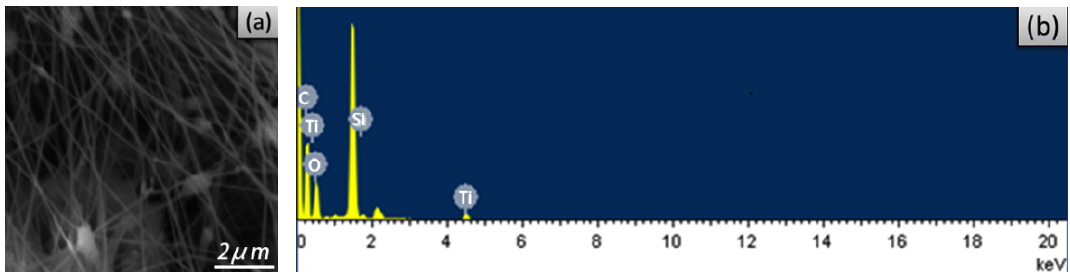
Figure 6. SEM image ( a ) and EDX spectrum ( b ) of electrospun xylan-g-PMMA/TiO 2 fibers. XPS analysis of electrospun xylan-g-PMMA/TiO 2 fibers was also performed (Figure 7), and it identified the peaks of Ti, Si, O, and C. The XPS spectrum of Si2p of electrospun xylan-g-PMMA/TiO 2 fibers showed that Si mainly existed in two forms (Figure 8). The two peaks of binding energy, EB, at 102.58 and 100.88 eV corresponded to Si-O and Si-C peaks [87,88], respectively, indicating that triethoxyvinylsilane reacted with O atoms on the surface of TiO 2 (Figure 9). This is because the surface of nano-TiO 2 contains a large number of hydroxyl groups, and the -Si(OH) 3 generated by the hydrolysis of -Si(OC 2 H 5 ) in triethoxyvinylsilane can react with hydroxyl groups, making triethoxyvinylsilane chemically bonded to the surface of nano-TiO 2 to form Ti-O-Si bonds.